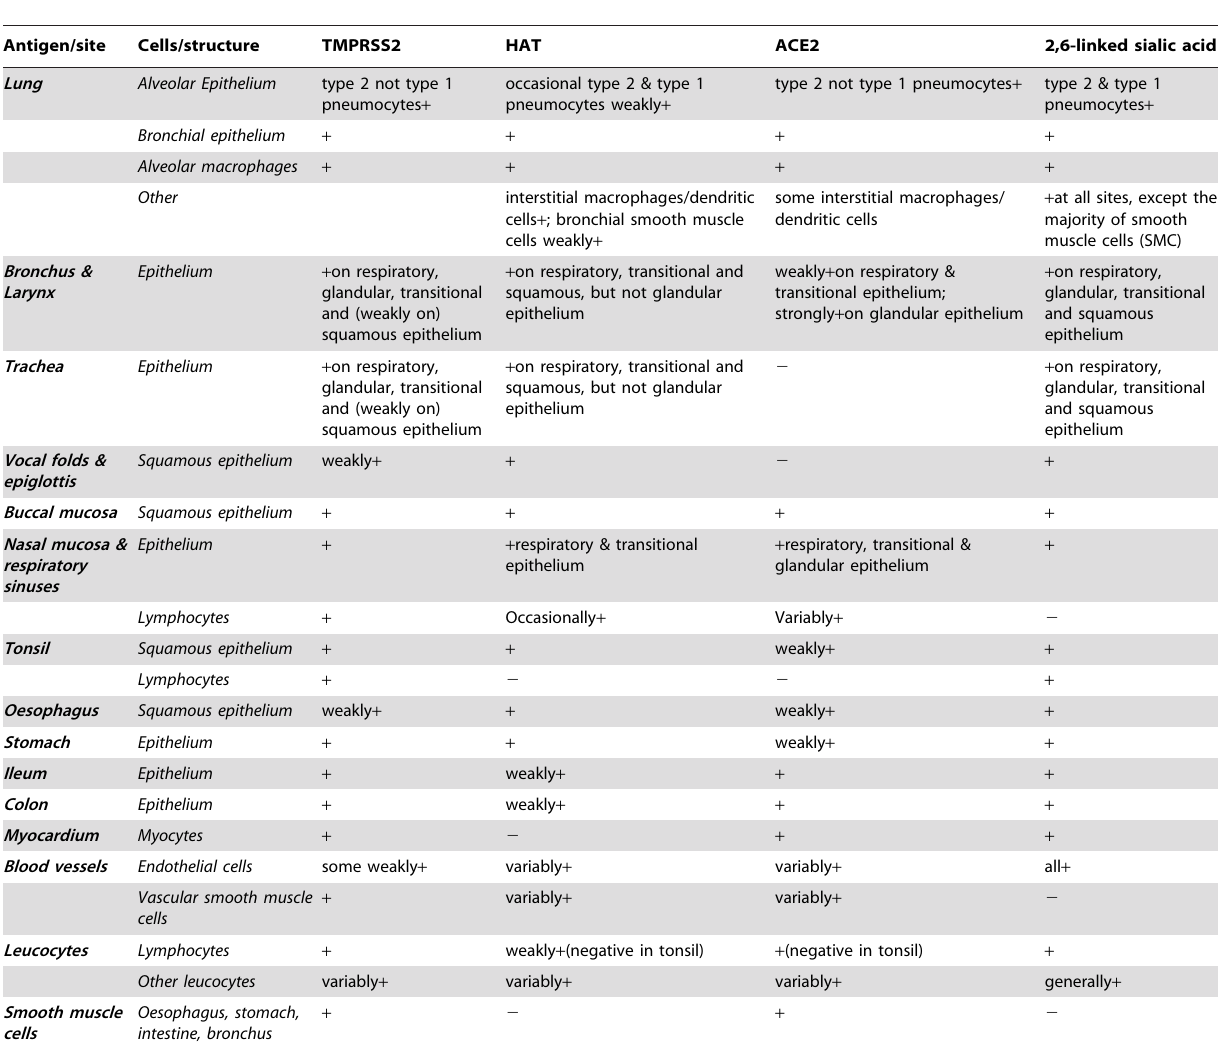
Cell types expressing TMPRSS2, ACE2, HAT, 2,6-linked sialic acid are marked + , while those that do not express these molecules are marked 2 . ‘‘weakly’’ refers to a low level of staining. doi:10.1371/journal.pone.0035876.t001 Figure S1 To detect SARS-S cleavage in trans, expres- sion plasmids coding for SARS-S and the indicated proteases or empty vector (pcDNA) were separately transfected into 293T cells. Subsequently, the SARS-S and protease expressing cells were mixed, treated with trypsin or PBS and S-protein cleavage was detected by Western blot analysis using a serum specific for the S1 subunit of SARS-S. SARS-S cleavage fragments produced by trypsin and TMPRSS2 are indicated by asterisks. Detection of ß-actin served as a loading control.